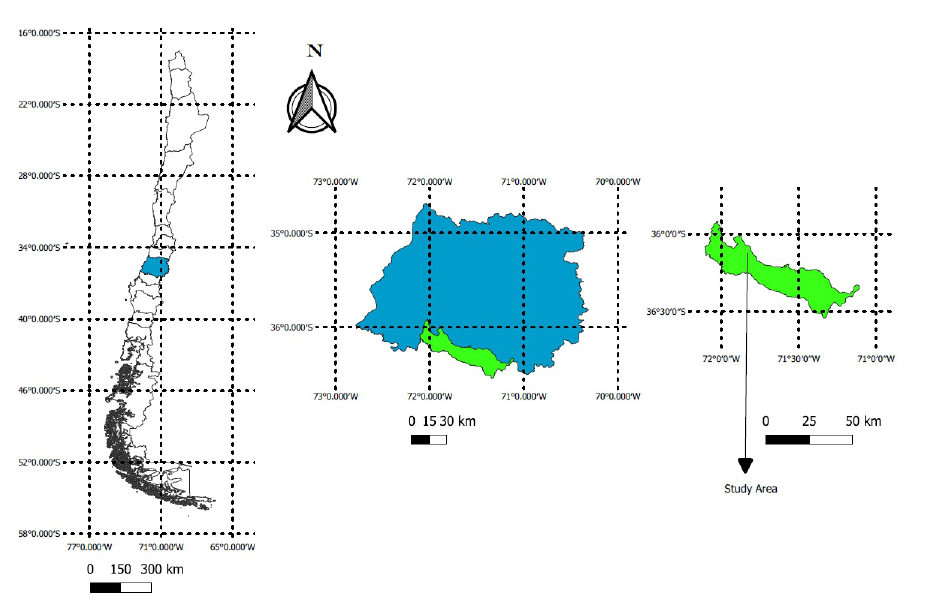
Figure 1. The geographic location of the study site. Parral, Maule Region, Chile (lat. 71°49 (cid:48) 53.29 (cid:48)(cid:48) W, long. 36°5 (cid:48) 56.21 (cid:48)(cid:48)